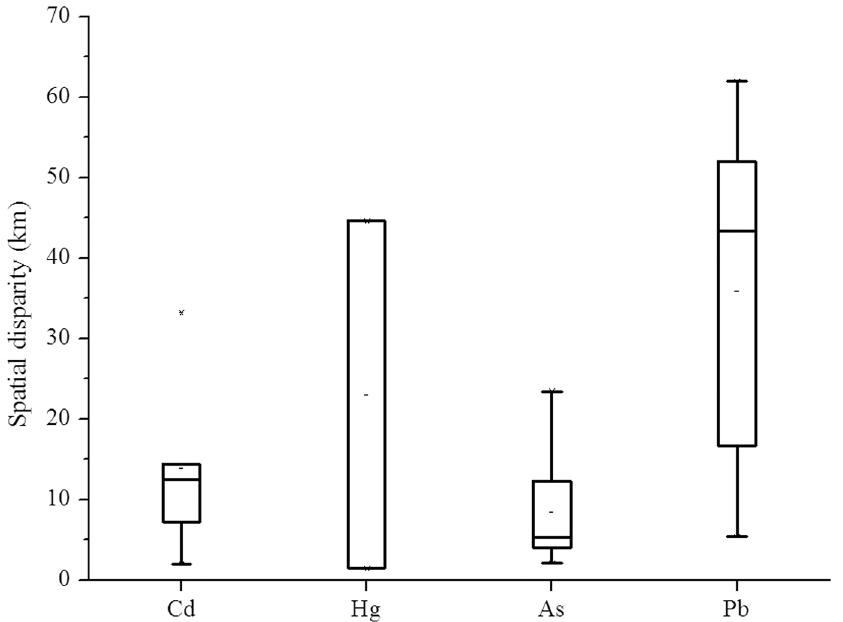
Fig 6. Spatial disparity of geometric centers in the surface and deep soil for heavy metals.